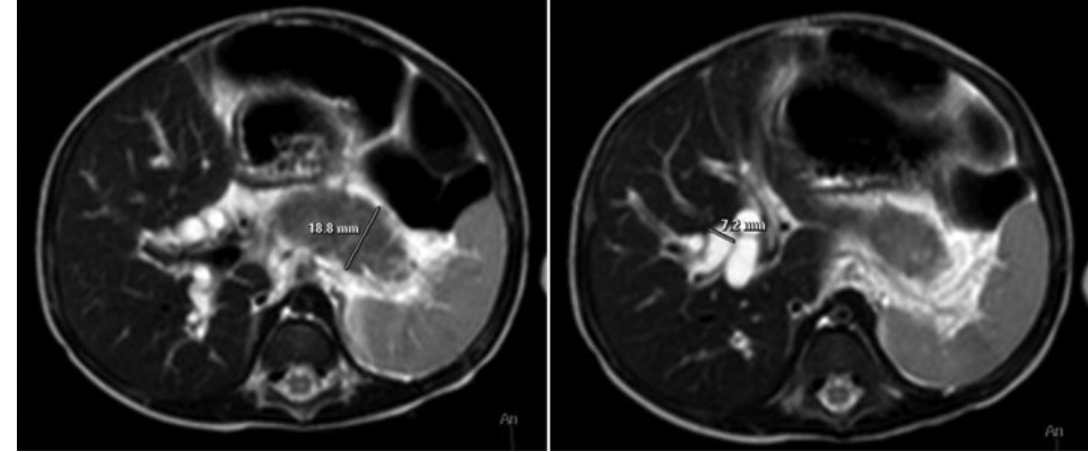
Fig. 1 Magnetic resonance fi ndings vascular tumor at the pancreatic head (3.3 (cid:1) 2.4 (cid:1) 1.8 cm) and a dilated biliary tract (7.2 mm).